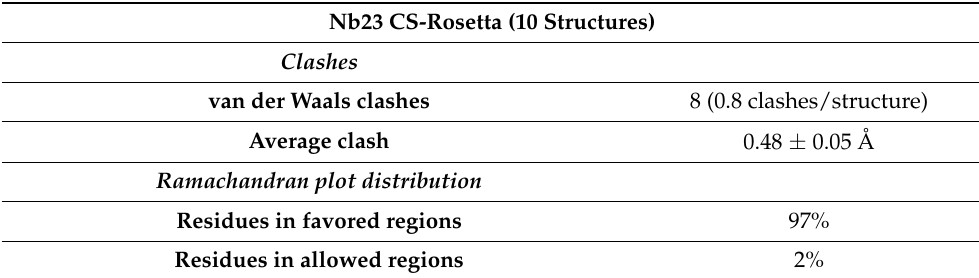
Table 2. Summary of features and violations for the CS-Rosetta ensemble, the NOE-restrained ensemble, and final NOE-restrained and energy minimized